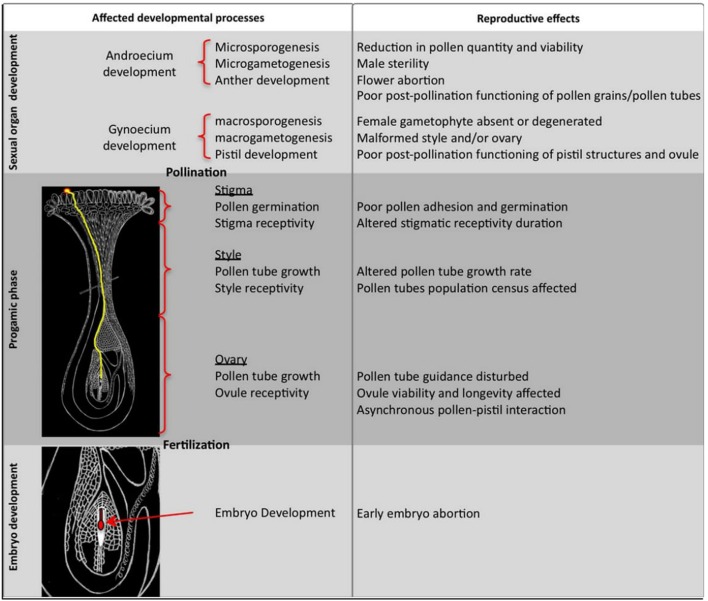
Impact of heat stress on pollen development and function during the sexual reproductive phase. The figure is reprinted with permission from Hedhly (2011).